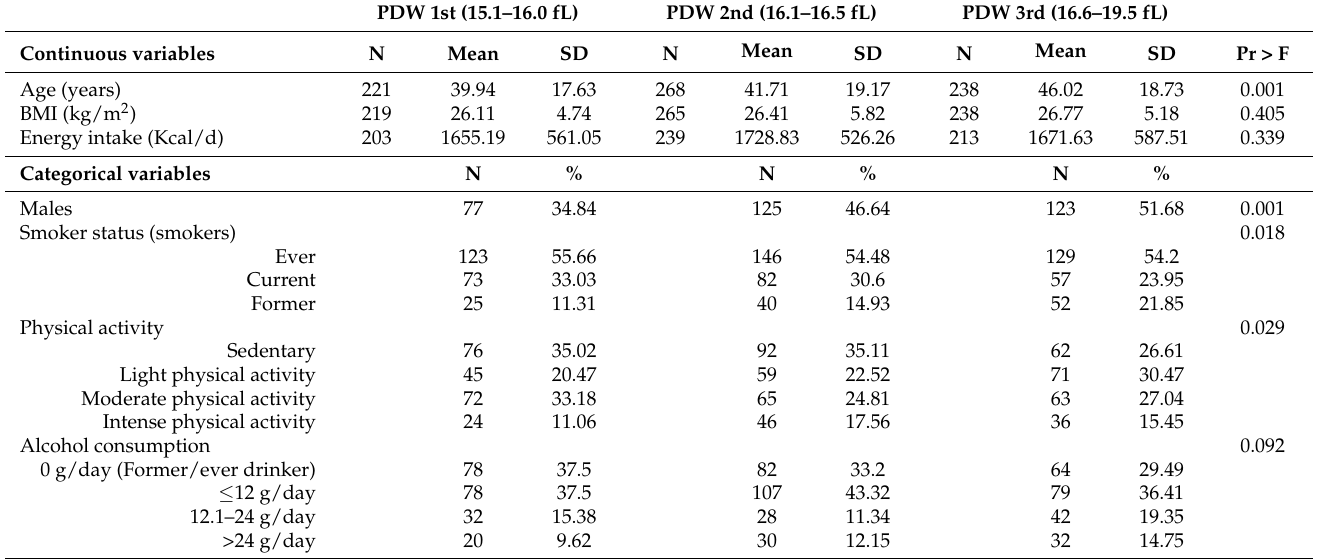
Table 1. Moli-family cohort characteristics by PDW